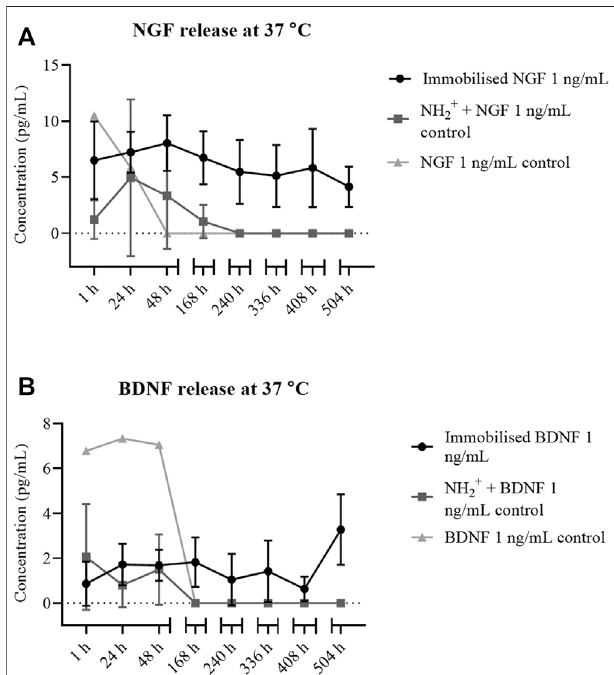
FIGURE 3 | NGF and BDNF release from NH 2+ + Heparin. (A) NH 2+ + Heparin + Immobilised NGF 1 ng/ml (circles), and NH 2+ (squares) at different time points, from 1 to 504 h (21 days). NGF at 1 ng/ml in solution in PBS was used as a control (triangles). (B) BDNF release from NH 2+ + Heparin + Immobilised BDNF 1 ng/ml (circles), and NH 2+ (squares) at different time points, from 1 to 504 h (21 days). BDNF at 1 ng/ml in solution was used as a control